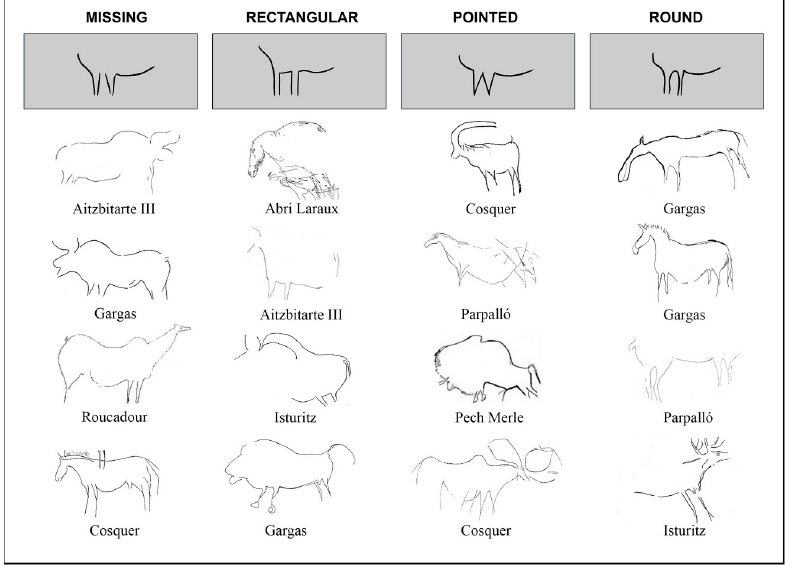
Fig 16. Different conventions to represent the connection between the two fore- or hind-limbs of herbivores: Aitzbitarte III [2], Isturitz [15], Cosquer [14], Gargas [12], Abri Laraux [67], Pech Merle [68], Parpallo´ [69], Roucadour